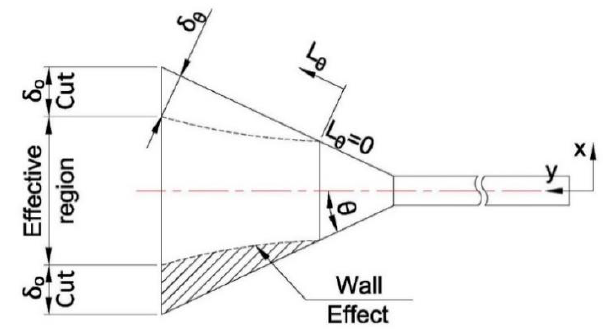
Figure 9. The schematic diagram for the cut regions near side walls.